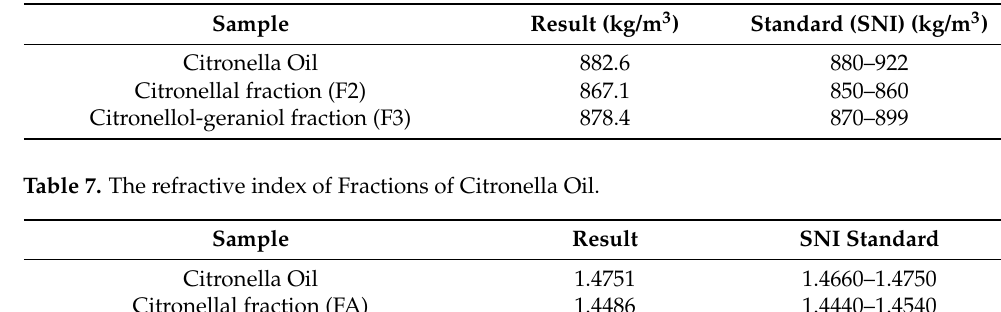
Table 6. Density of Fractions of Citronella Oil.